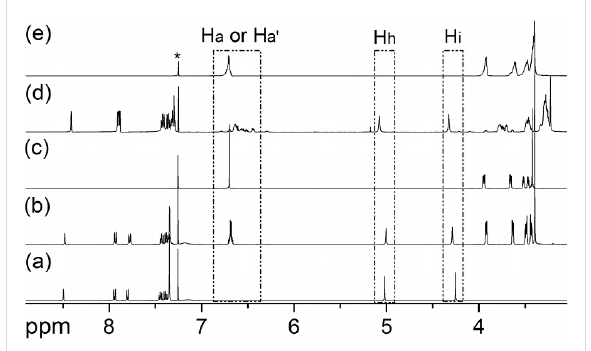
Figure 1: 1 H NMR spectra (500 MHz, 298 K, CDCl 3 :CD 3 CN = 2:1, 10.0 mM) of 5 -H•PF 6 ( a ), mixture of 5 -H•PF 6 and C7 ( b ), C7 ( c ),